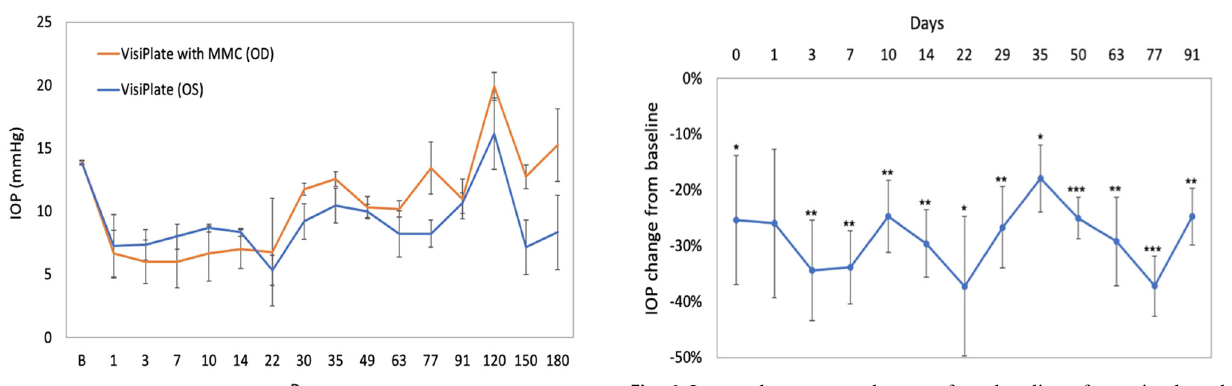
Fig. 4 Intraocular pressure decrease from baseline of eyes implanted with VisiPlate alone across all groups ( n = 6), presented as mean ± SE. There was a signi fi cant reduction from baseline rabbit IOP of 15 mmHg exceeding the FDA ’ s ef fi cacy threshold of 20% IOP reduction from baseline. * p < 0.05, ** p < 0.01, *** p < 0.001, paired one-tailed Student ’ s t test